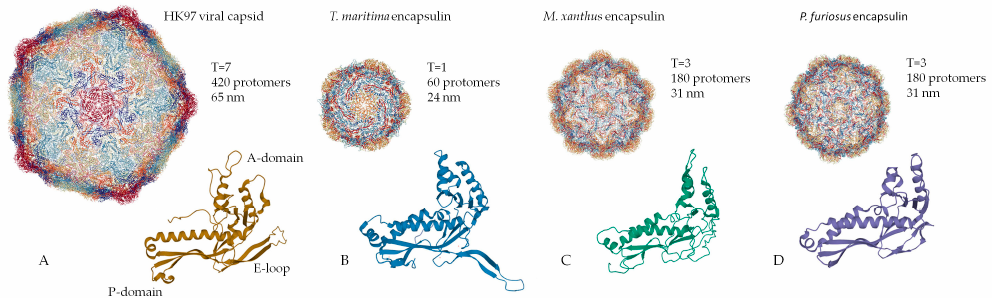
Figure 1. Structural comparison of the capsomers/monomers and assembled capsid/encapsulins: ( A ) HK97 phage, ( B ) Thermotoga maritima encapsulin, ( C ) Myxococcus xanthus encapsulin, ( D ) Pyrococcus furiosus encapsulin. (PDB-ID: 2FT1, 3DKT, 4PT2, and 2E0Z, respectively).